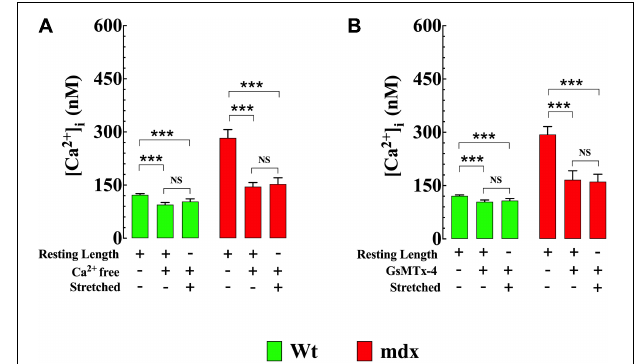
FIGURE 8 | Reducing Ca 2 + influx inhibits stretch-induced elevation of [Ca 2 + ] i in VSMCs. Removal of extracellular [Ca 2 + ] (A) or blocking the mechanosensitive channels using GsMTx4 (5 µ M) (B) reduced [Ca 2 + ] i and abolished the increase in [Ca 2 + ] i in response to stretch (20% of resting length) in both genotypes. For [Ca 2 + ] i : n mice = 5/experimental condition, n cell = 13–19/genotype. Values are expressed as means ± S.D. for each condition. Student’s t -test, *** p ≤ 0.001.